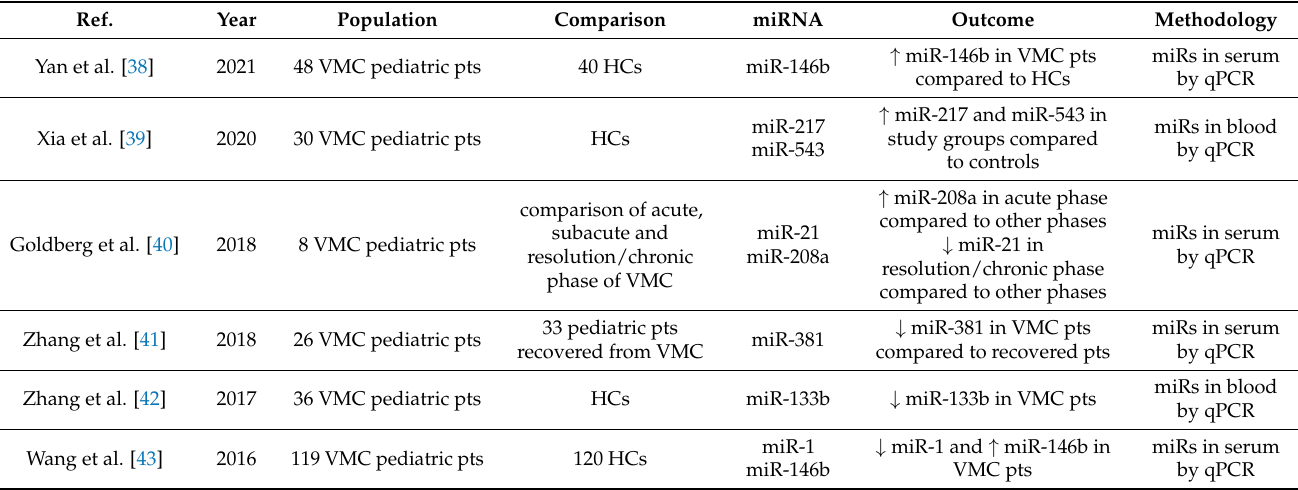
Table 1. Summary of recent studies regarding microRNAs in pediatric myocarditis